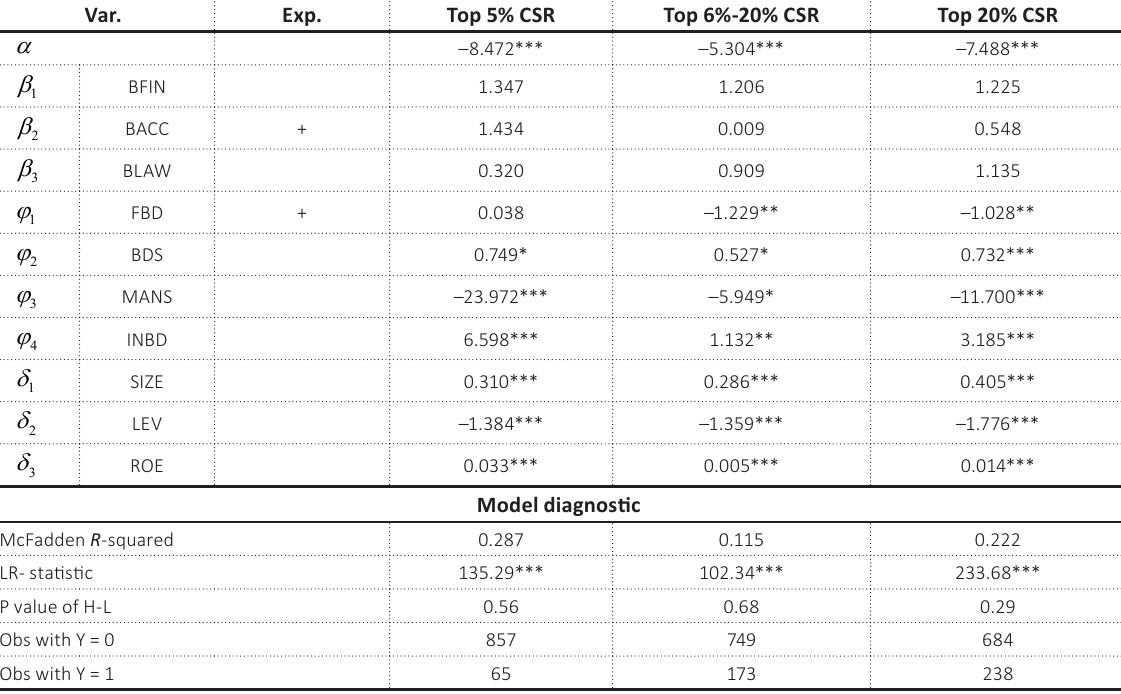
Table 5. The impact of Board gender and Accounting background on CSR (probit regression analysis for the case of 9-11 board